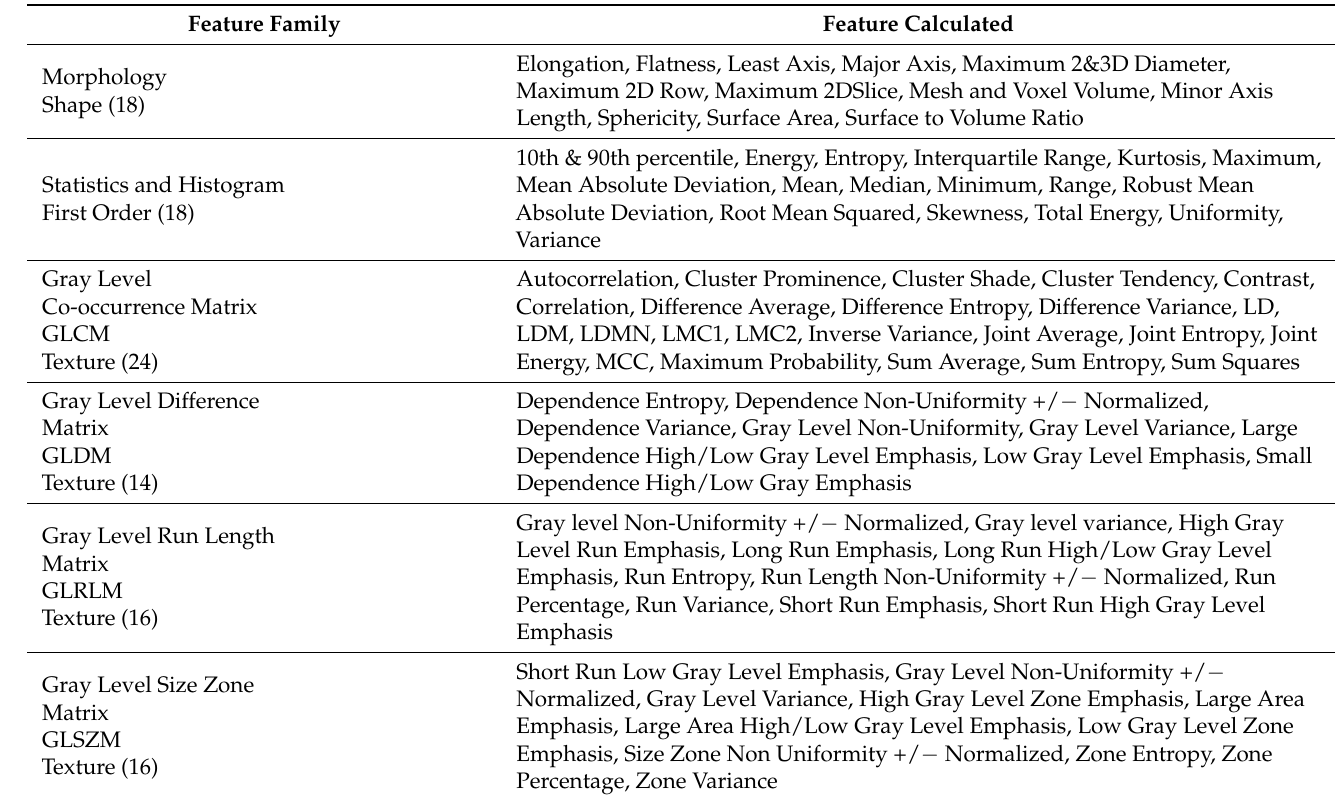
Table 1. Summary of the radiomic feature families and the specific features